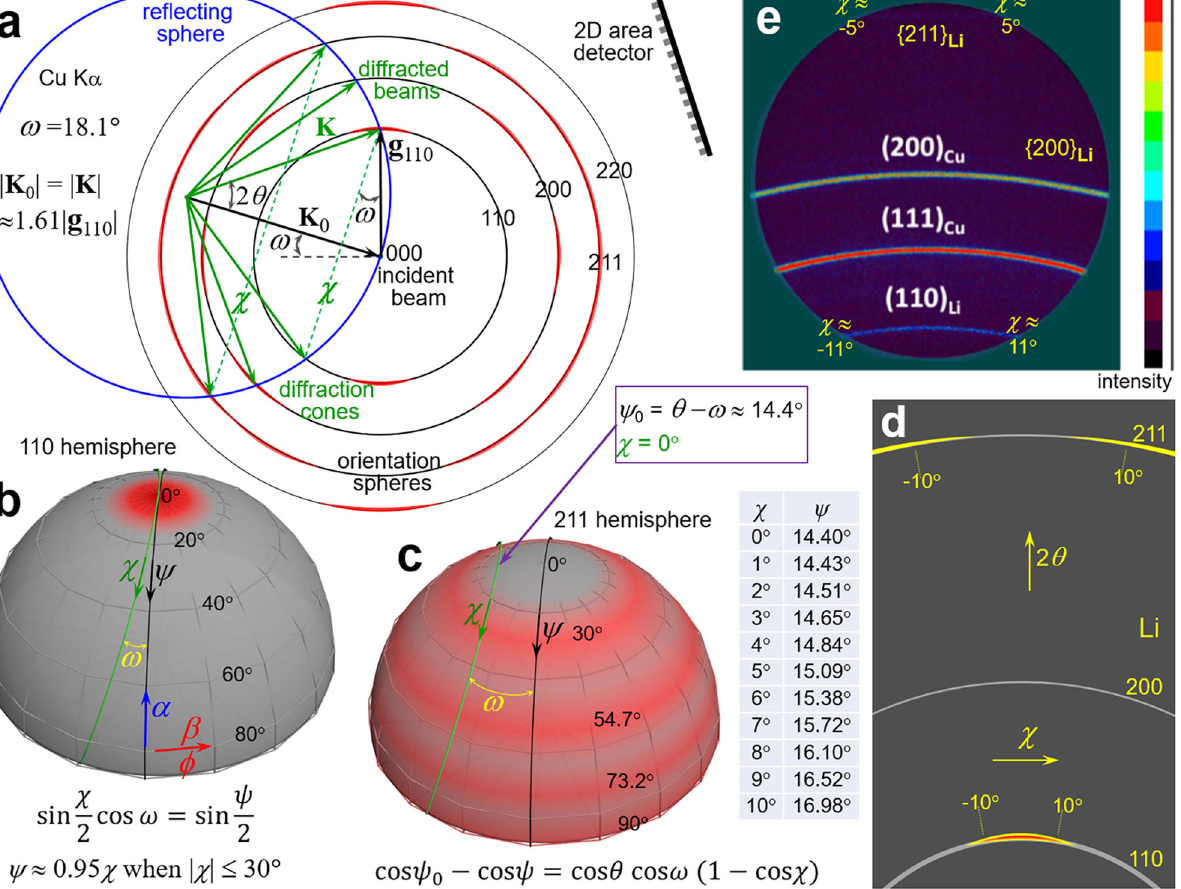
enhanced pole density. c {211} orientation hemisphere showing the broadenings and overlapping of fourlatitude-zones centered at ψ =30°,54.74°,73.22°,and